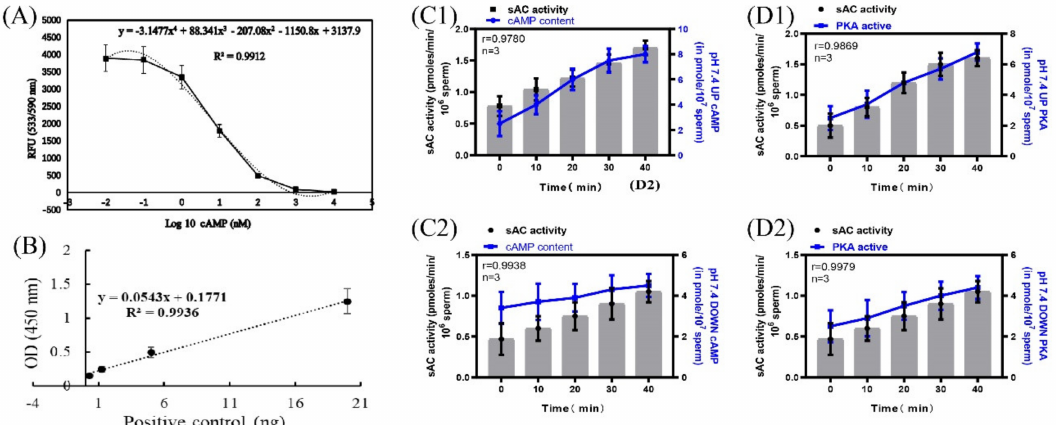
Figure 5. Correlation of sAC protein activity with cAMP and PKA protease activity. ( A ) Standard curve of cAMP content and OD533 RFU. ( B ) Standard curve of PKA concentration and OD450 RFU. ( C1 , C2 ) Correlation between sAC protein activity and cAMP content. ( D1 , D2 ) Correlation between sAC protein activity and PKA protease activity. Results are expressed as mean ± SEM, n = 3 experiments. Two-way ANOVA and Bonferroni’s multiple comparison test.